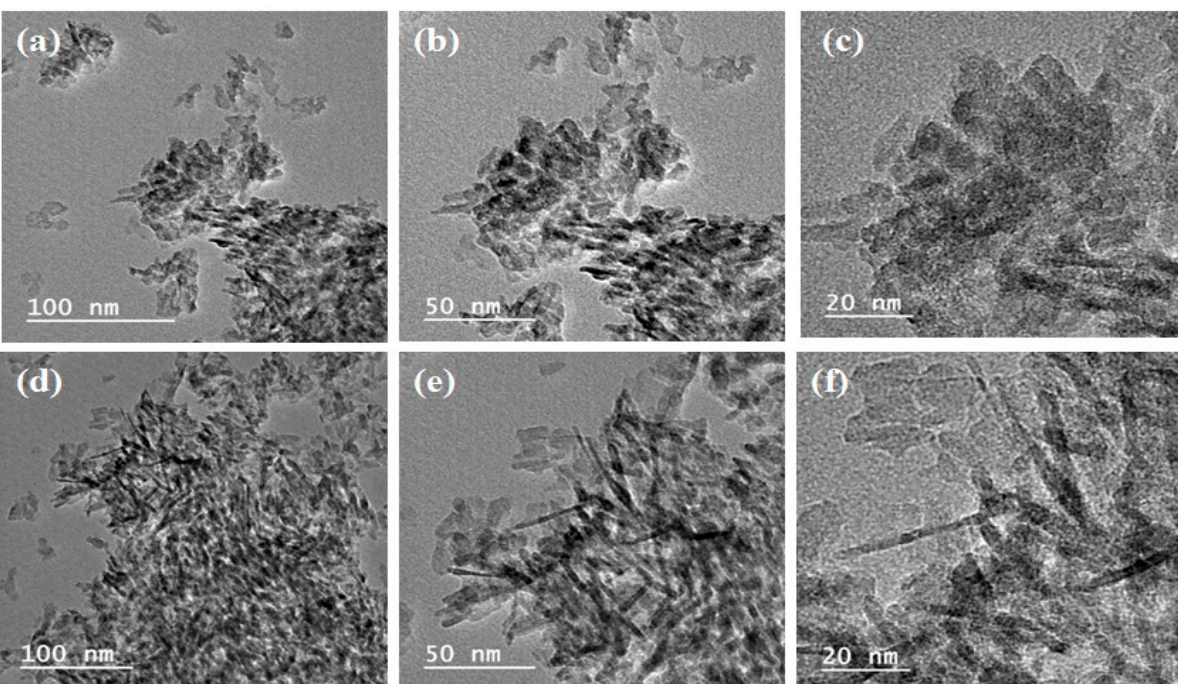
Figure 5. TEM images of Y-Zeolite ( a – c ) and Cu-Y-Zeolite ( d – f ). The TEM images of the Cu-ZSM5 catalyst is displayed in Figure 6a–c. These images show that particles of catalyst Cu-ZSM5 are angular in shape with high agglomeration. Also, image (Figure 6c) with a highly magnified view of the catalyst shows the formation of angular shape particles arrange in net-like structure morphology.